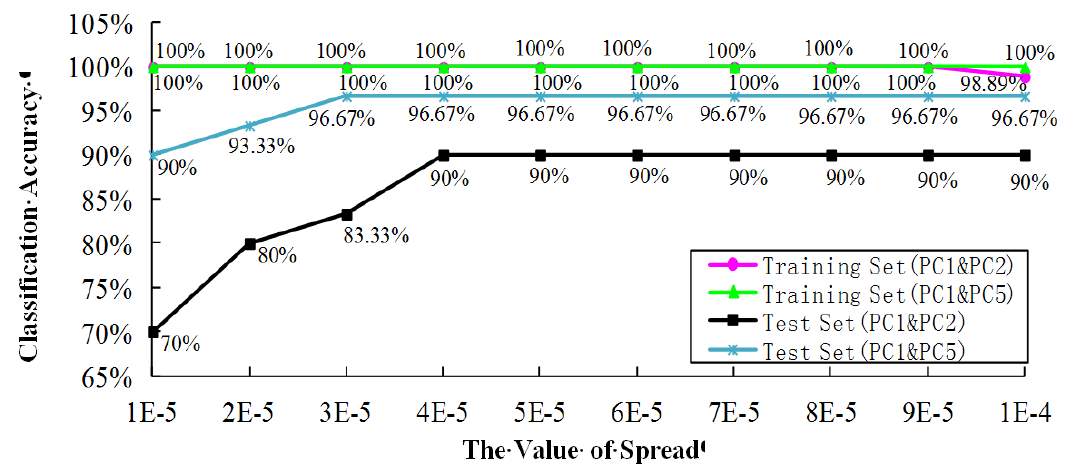
Figure 9. The selection of the spread value for a